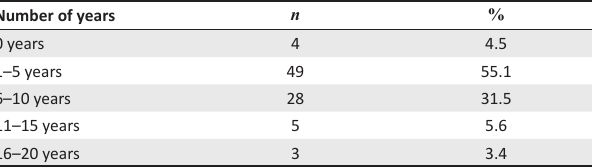
TABLE 1: Frequencies for number of years using information and communication technologies to teach mathematics. Number of years n